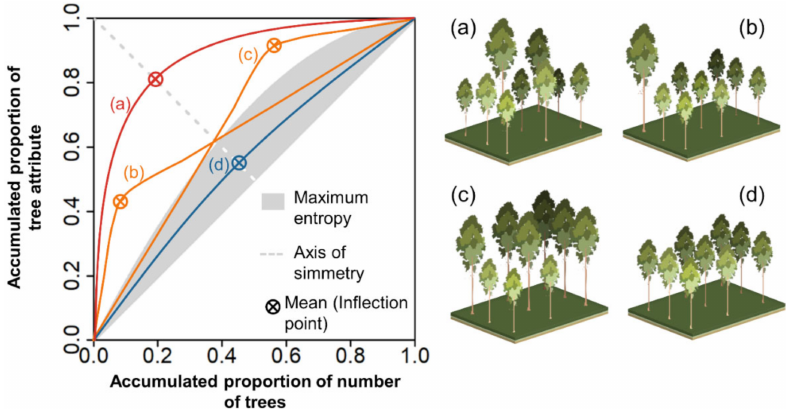
Figure 3. Theoretical Lorenz curves for ( a ) symmetric uneven-sized stands (balanced cohorts, i.e., trees with multiple sizes), ( b , c ) asymmetric uneven-sized stands (one cohort dominates over others), and ( d ) even-sized stands (single cohort). Trees were ranked in decreasing order, and the Lorenz curves were plotted with the cumulative percentage of trees ( x -axis) against the cumulative percentage of the tree attribute ( y -axis).